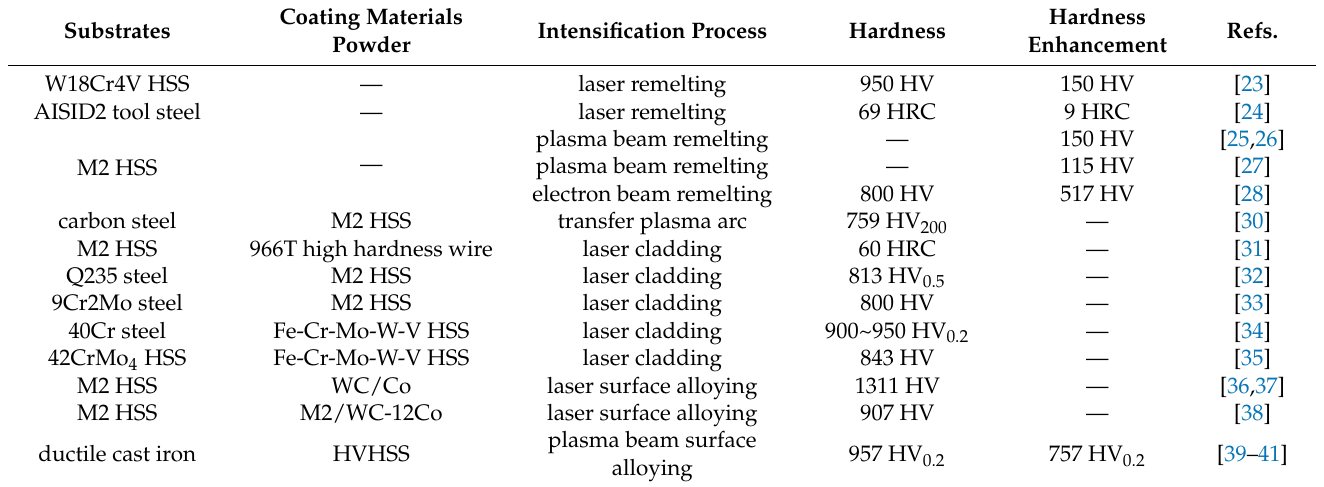
Table 2. Hardness enhancement effects of different intensification